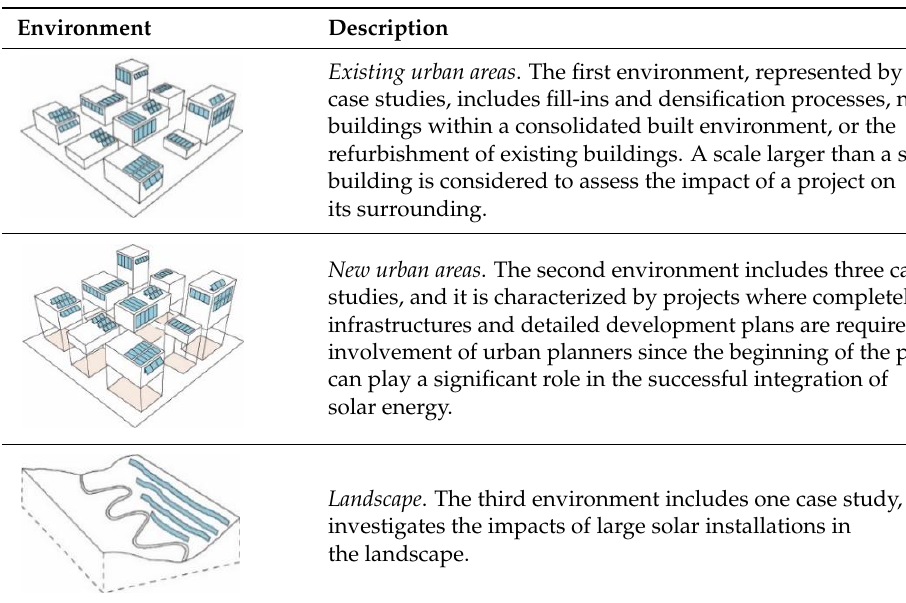
Table 1. Classification of the environments.